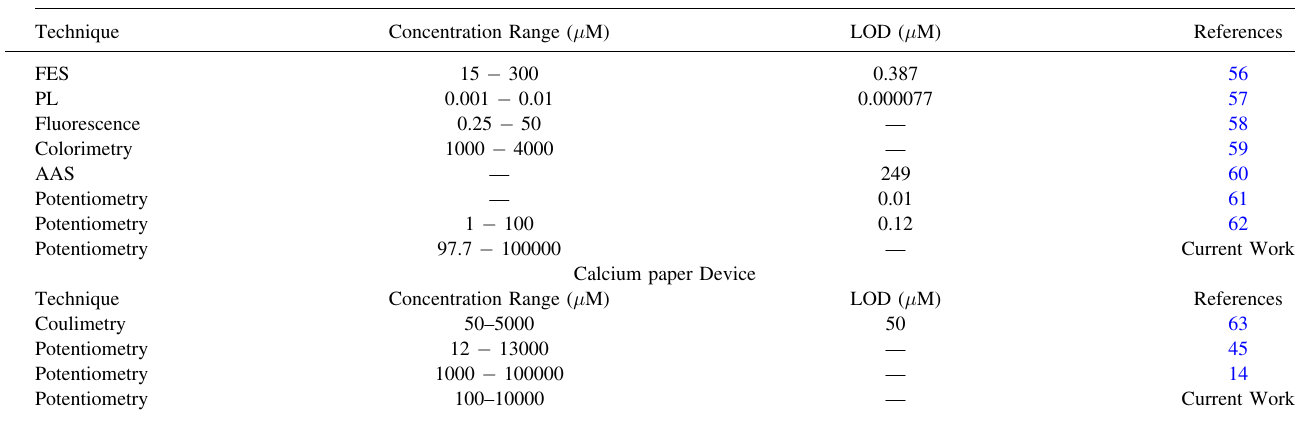
Table II. Comparative table of analytical techniques and paper-based devices used to detect Ca 2+